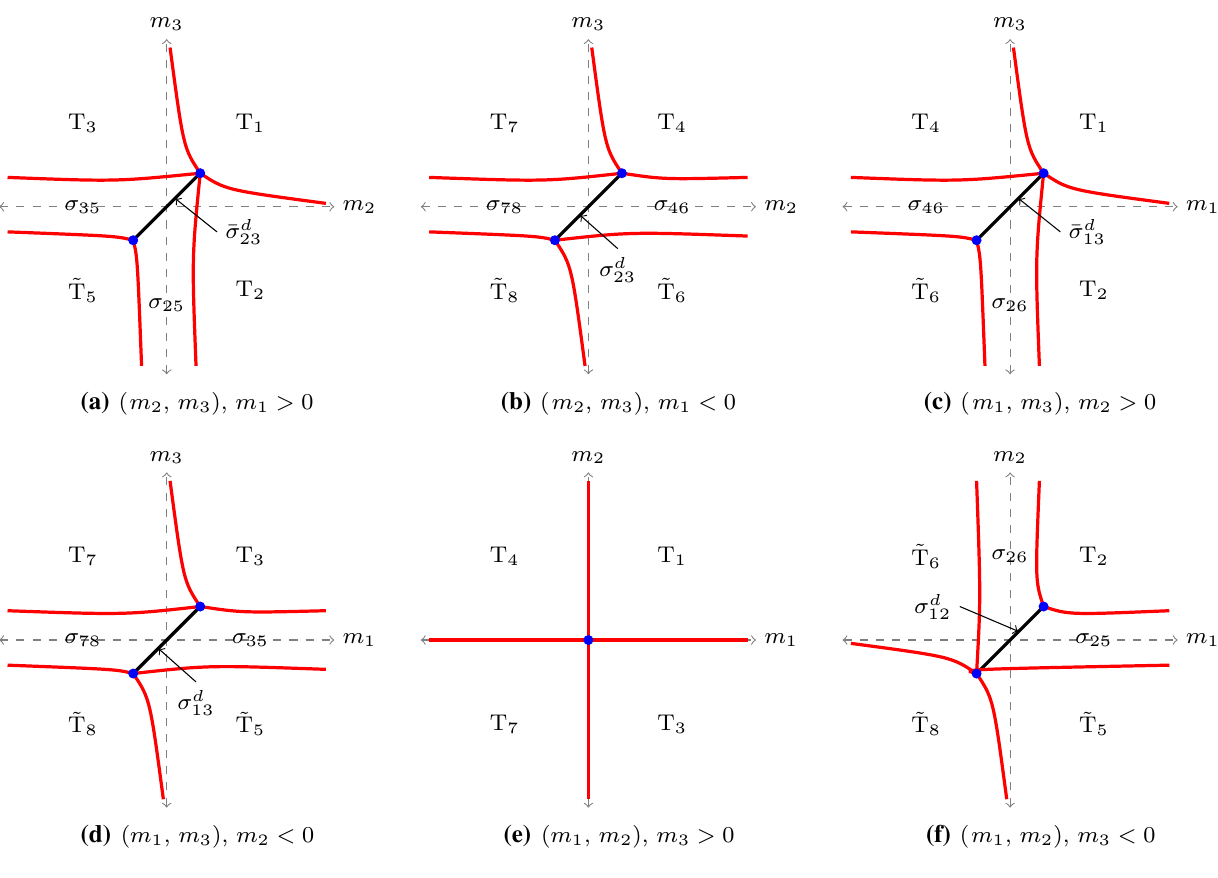
Fig. 10 Phases of SU ( N ) k + p ψ 1 + q ψ 2 + ( F − p − q )ψ 3 with ( p + q ) − F / 2 ≤ k < F / 2 − p